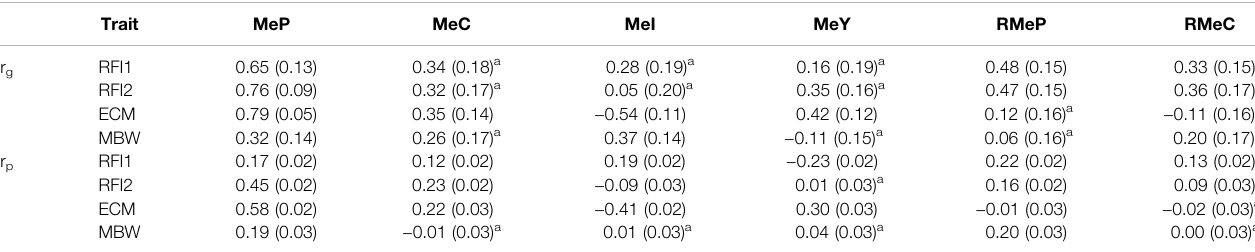
TABLE 4 | Estimated genetic (r g ) and phenotypic (r p ) correlations with (SE) between methane traits and production, maintenance, and ef fi ciency traits. Trait MeP MeC MeI MeY RMeP RMeC r g